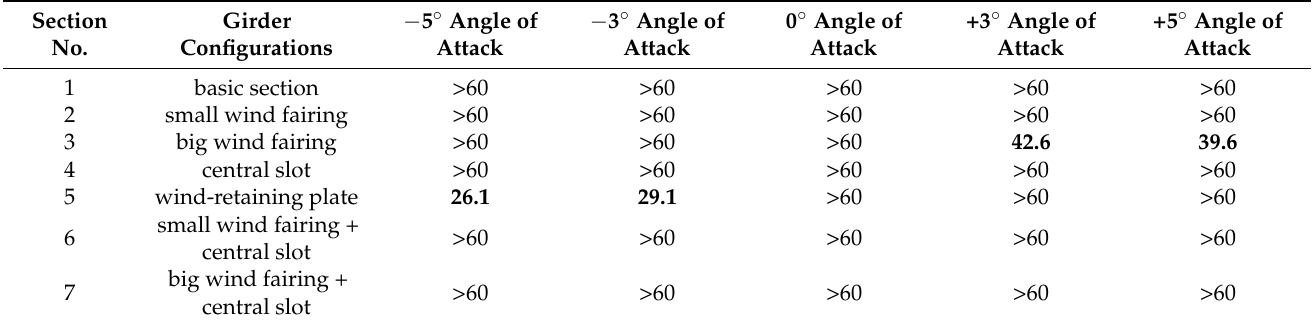
Table 5. Critical flutter wind velocities for various aerodynamic measures